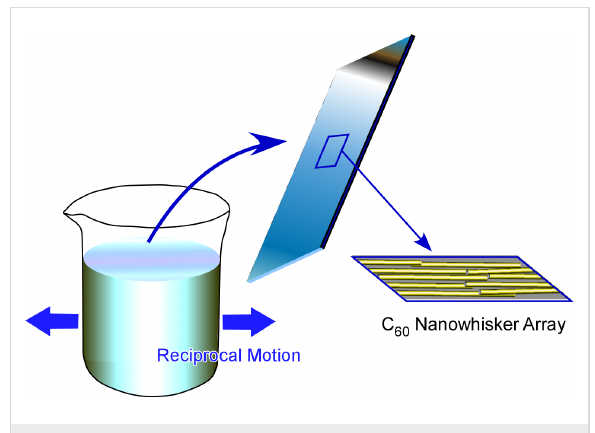
Figure 28: Highly aligned arrays of C 60 nanowhiskers obtained by using a LB method with reciprocal motion in one direction for differenti- ation control of neural stem